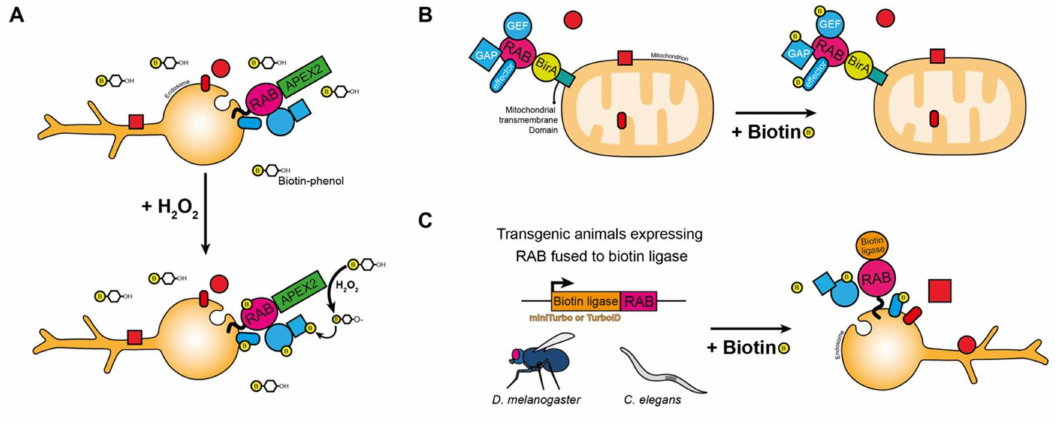
Figure 2. Proximity labeling approaches to characterize Rabs neighboring proteins in vitro and in vivo. ( A – C ) Scheme illustrating the di ff erent proximity labeling approaches used in vitro ( A , B ) and in vivo ( C ). ( A ) APEX2, ( B ) BirA and ( C ) miniTurbo or